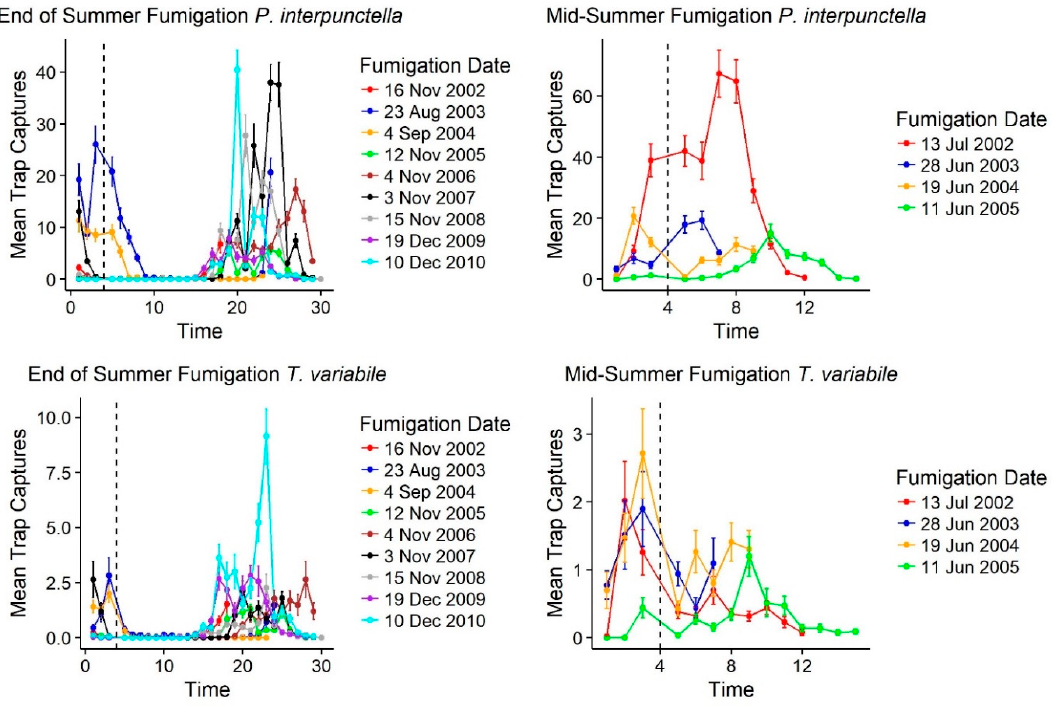
Figure 6. Line graphs of fumigation response. Time is represented by trapping period with fumigation date centered by vertical dashed lines at time 4 (x-axis); 3 trapping periods before, to visualize pre-fumigation counts, and 14 trapping periods after, to visualize rebound are represented. Fumigation periods are separated if they occurred towards the end of the warm season (end-of summer) or during the warm season (mid-summer) fumigations to show the differences in rebound.